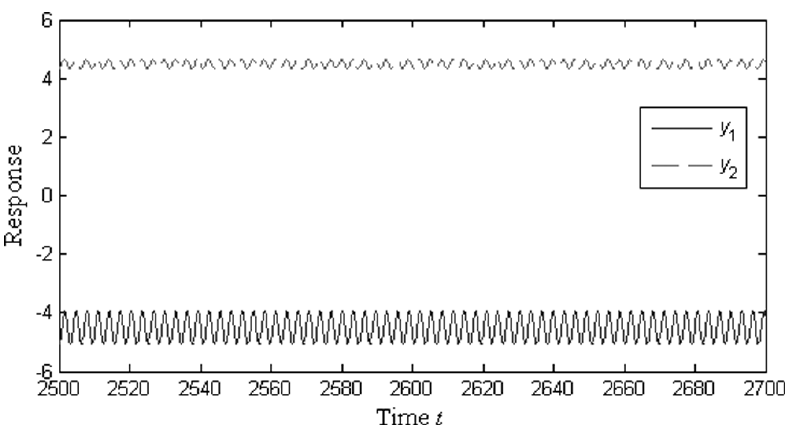
Fig. 21. Time history with feedback control, τ = 1 ,β 11 = β 12 = β 21 = β 22 = − 10, ( y 1 ,y 2 , ˙ y 1 , ˙ y 2 ) = (0.5,0.5,0,0).